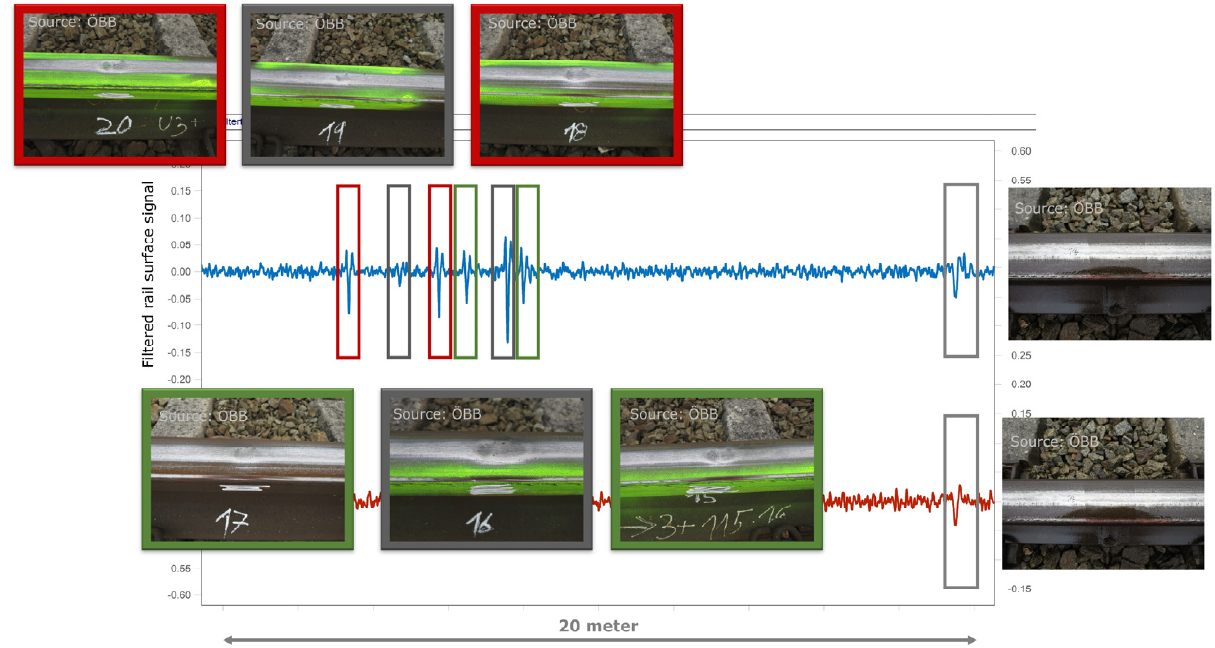
Figure 5. A comparison of the signal characteristics of the measurement system with documented squats .